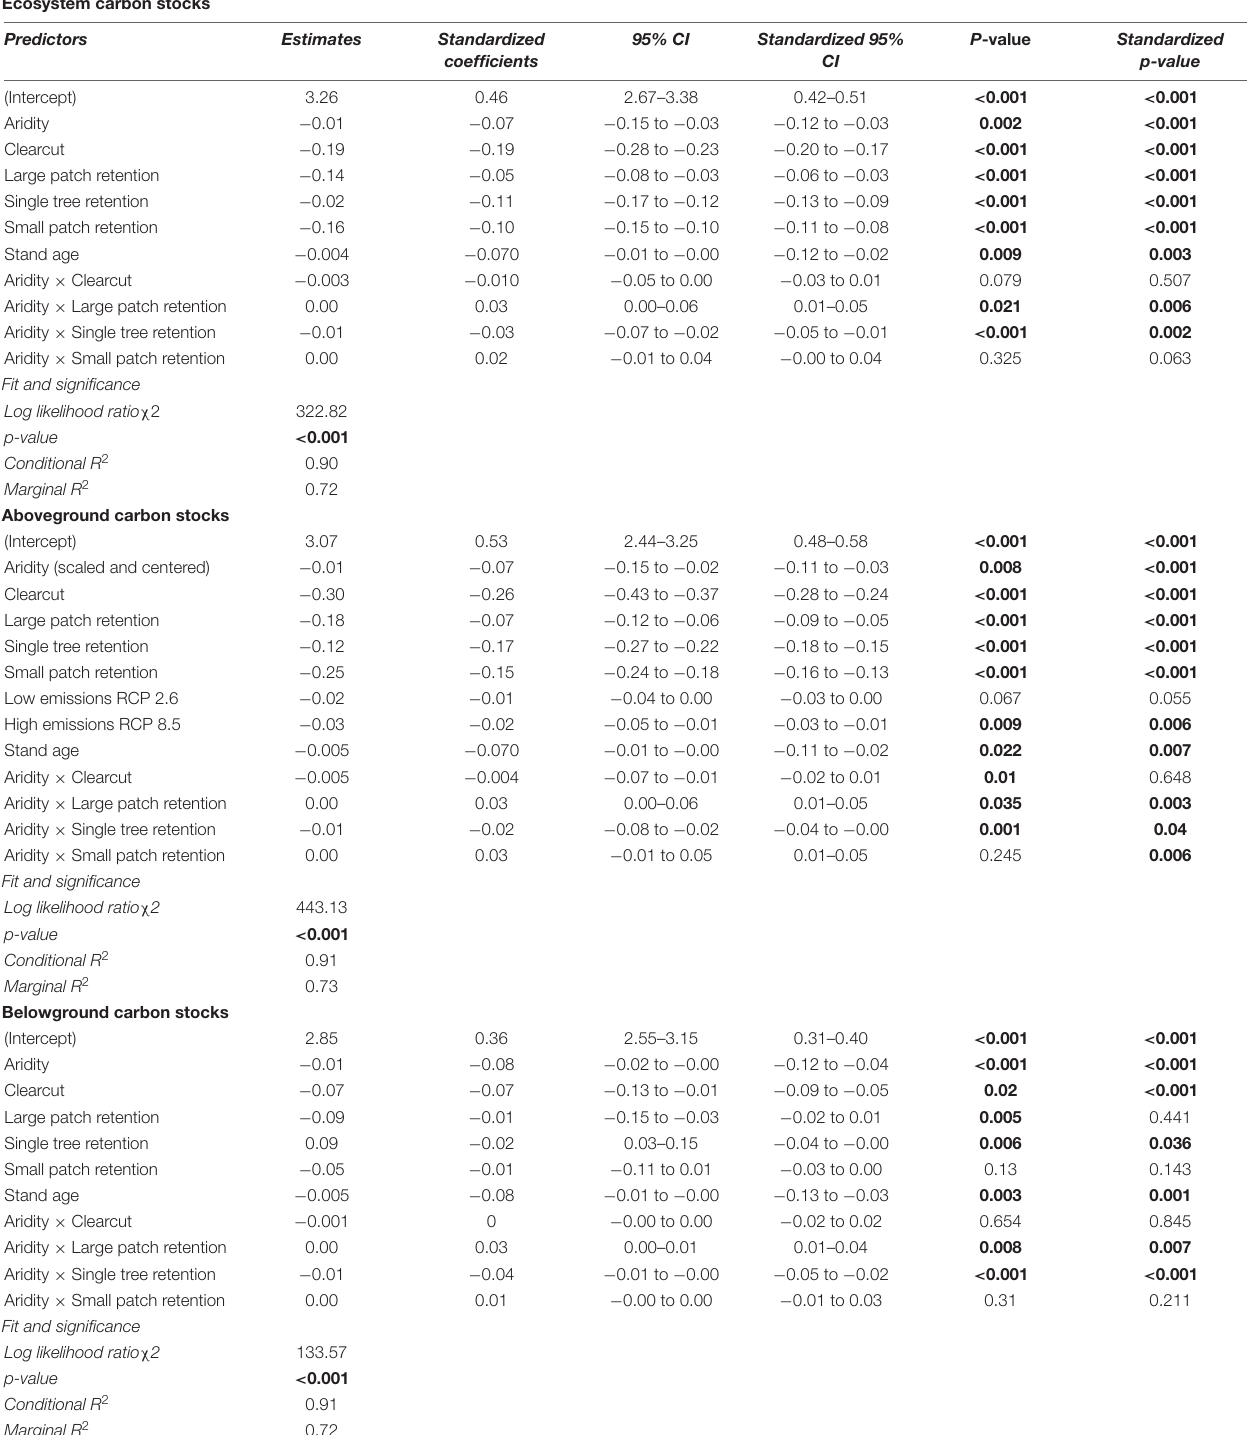
TABLE 3 | Effect of harvesting intensity, climatic aridity (1981–2010 averages) and climate change (low-emissions RCP 2.6 and high-emissions RCP 8.5) on model projected Douglas-fir forest carbon stocks (2019–2069; log 10 -transformed; no growth multiplier; n = 3 for all locations, except for Two-bit where n = 2 and Venables where n = 2 for the uncut